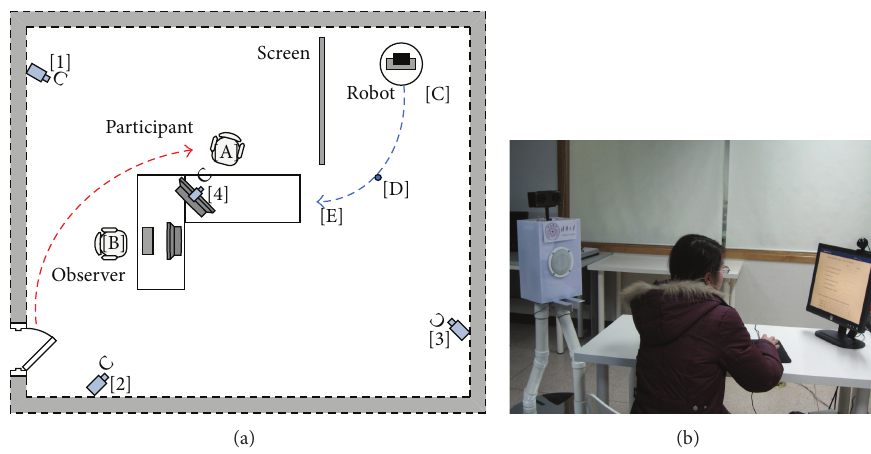
Figure 2: Layout of the lab (a); a participant is carrying out the experimental task with the robot